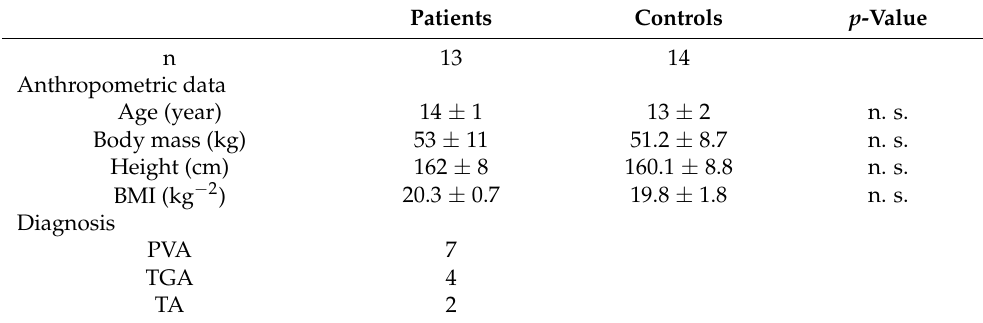
Table 1. Characteristics of children with congenital heart disease (CHD) and control subjects.